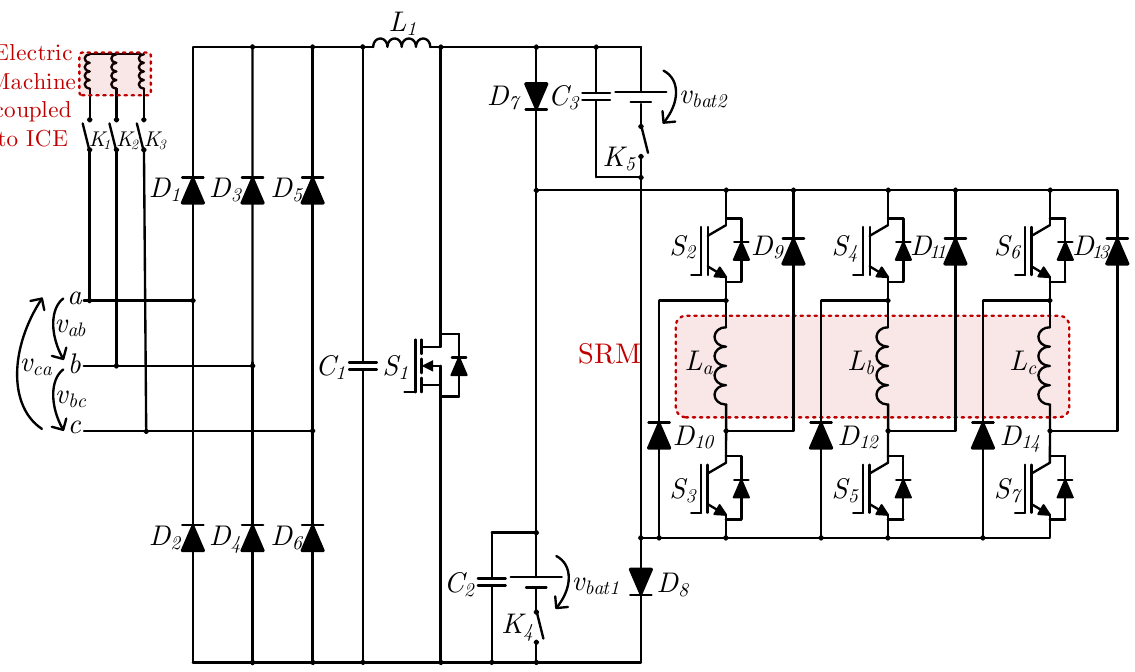
Figure 10. IBC for plug-in hybrid vehicles based on SRMs proposed by M. Ma et al. in 2018 [24].